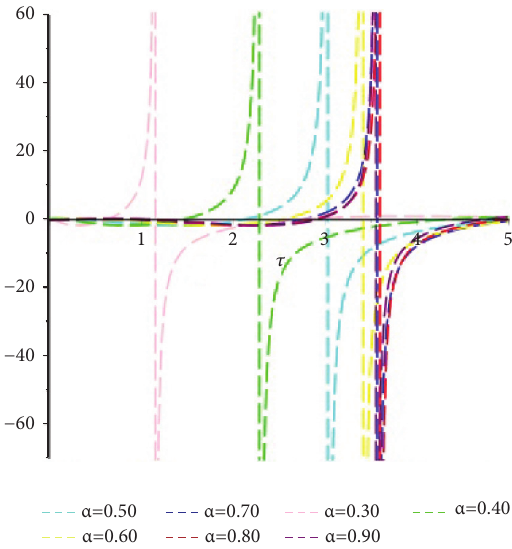
Figure 5: 2D with the real part of the solution Ψ